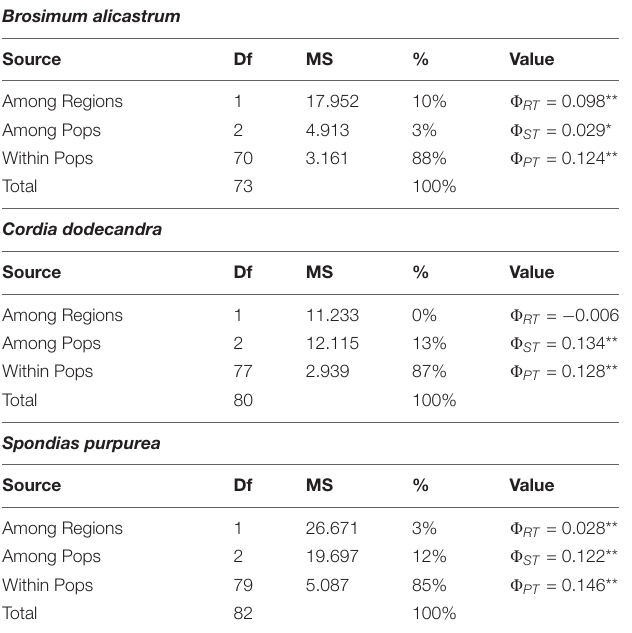
TABLE 4 | AMOVA results for the data estimated from ISSRs markers in three species of multipurpose trees from Northeast and Southwest regions in Yucatan, México, and two population types (within region) -forest and homegardens.